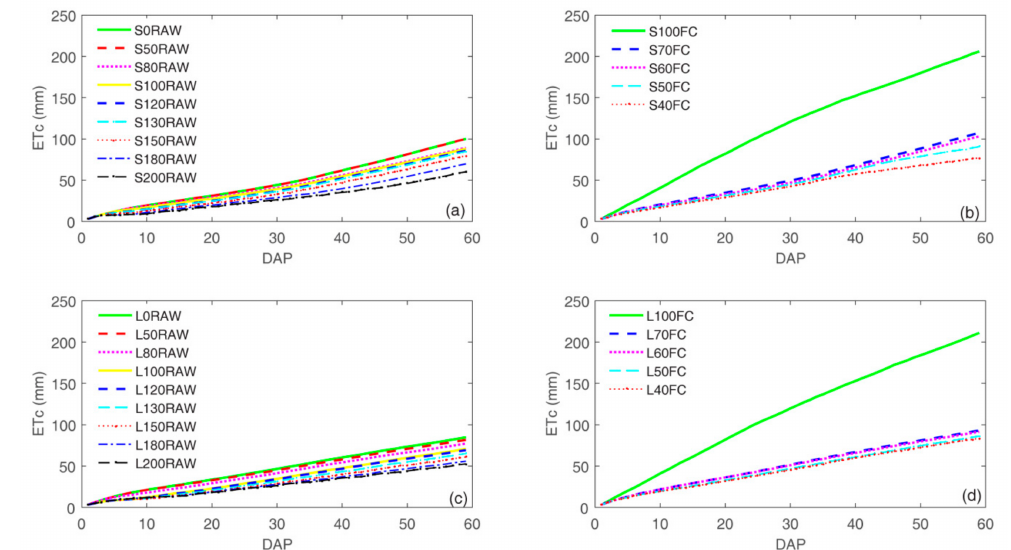
Figure 10. Crop evapotranspiration accumulation responses to different scenarios: ( a ) varied RAW threshold irrigation scenarios at site S1 (sand soil); ( b ) varied field capacity threshold irrigation scenarios at site S1; ( c ) varied RAW threshold irrigation scenarios at site S2 (loam soil); ( d ) varied field capacity threshold irrigation scenarios at site S2. RAW is readily available water content, S0RAW-S200RAW refers to irrigation scenarios with irrigation at 0–200% of RAW for sand soil. L0RAW-L200RAW refers to irrigation scenarios with irrigation at 0–200% of RAW for loam soil. S40FC-S100FC refers to deficit irrigation at 40–100% of field capacity for sand soil. L40FC-L100FC refers to deficit irrigation at 40–100% of field capacity for loam soil.